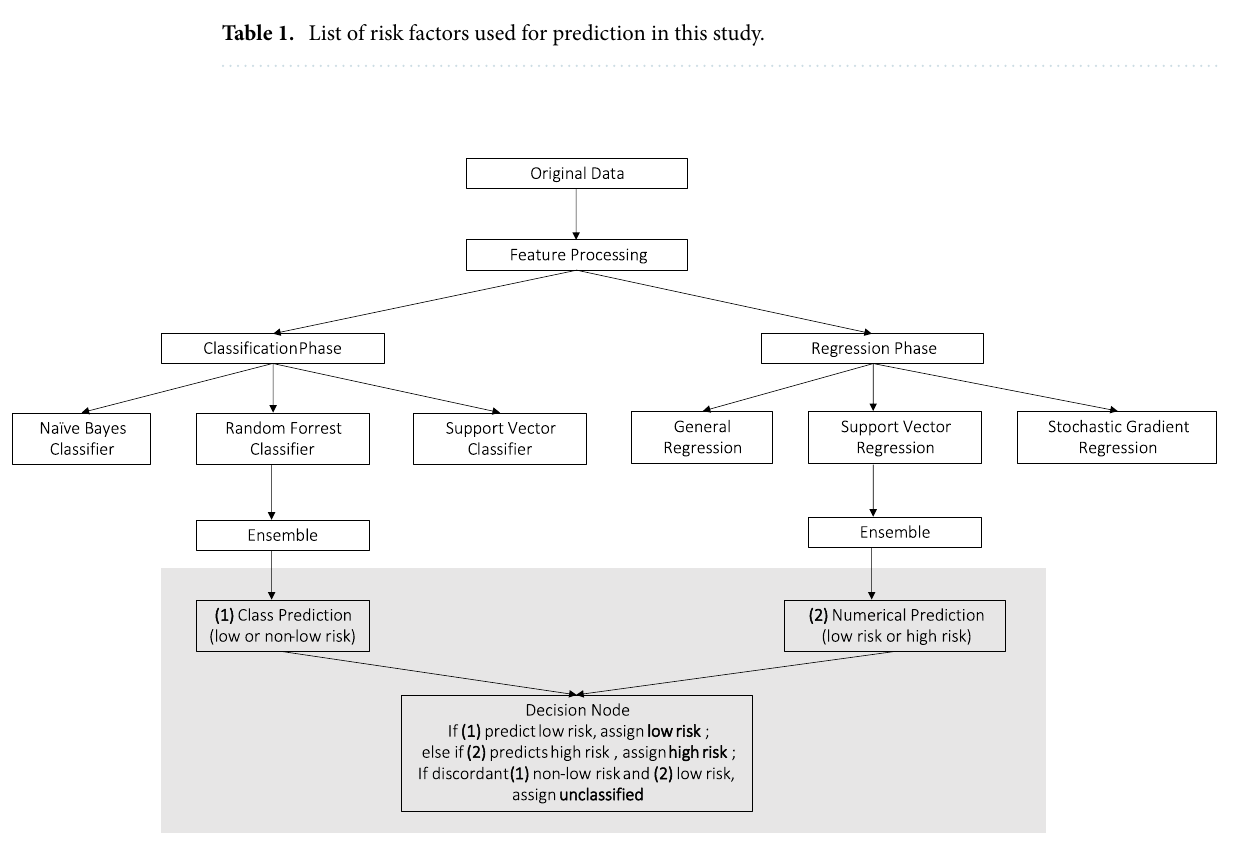
Figure 1. Modelling flow chart using ensemble MLA for cardiovascular risk